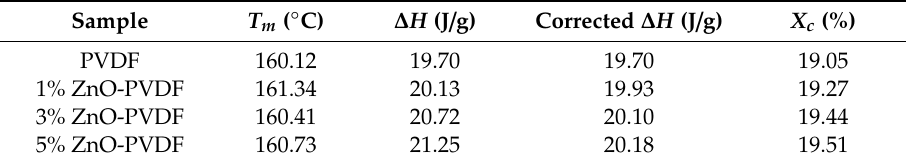
Table 3. Enthalpy and % crystallinity values obtained from the di ff erential scanning calorimetry (DSC)